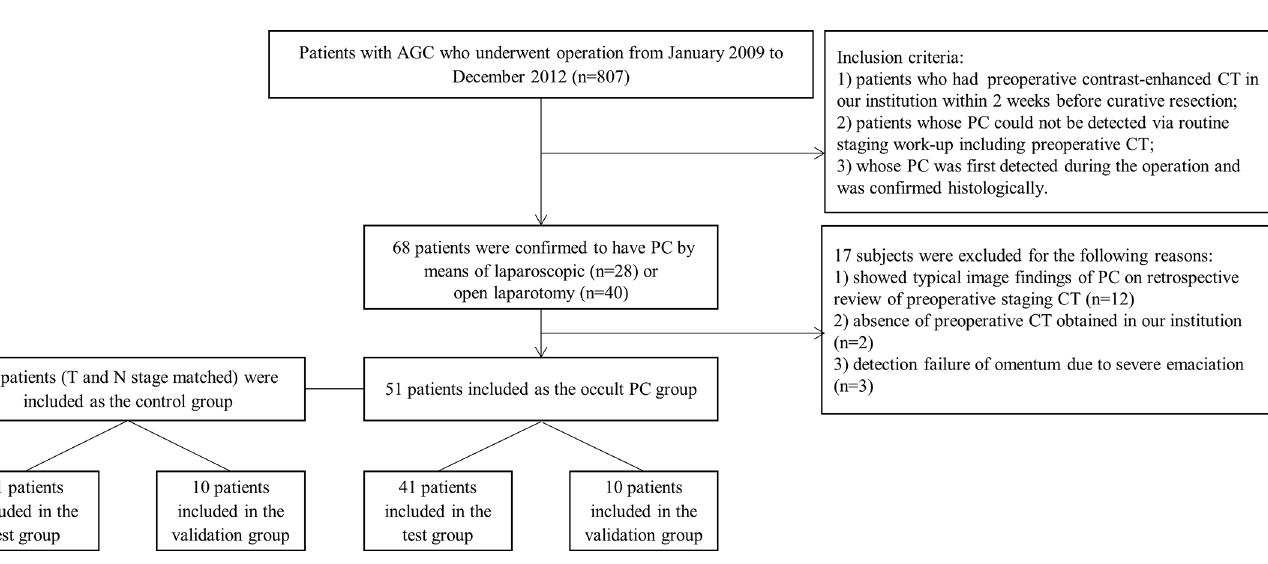
PLOS ONE | https://doi.org/10.1371/journal.pone.0194755 March 29,